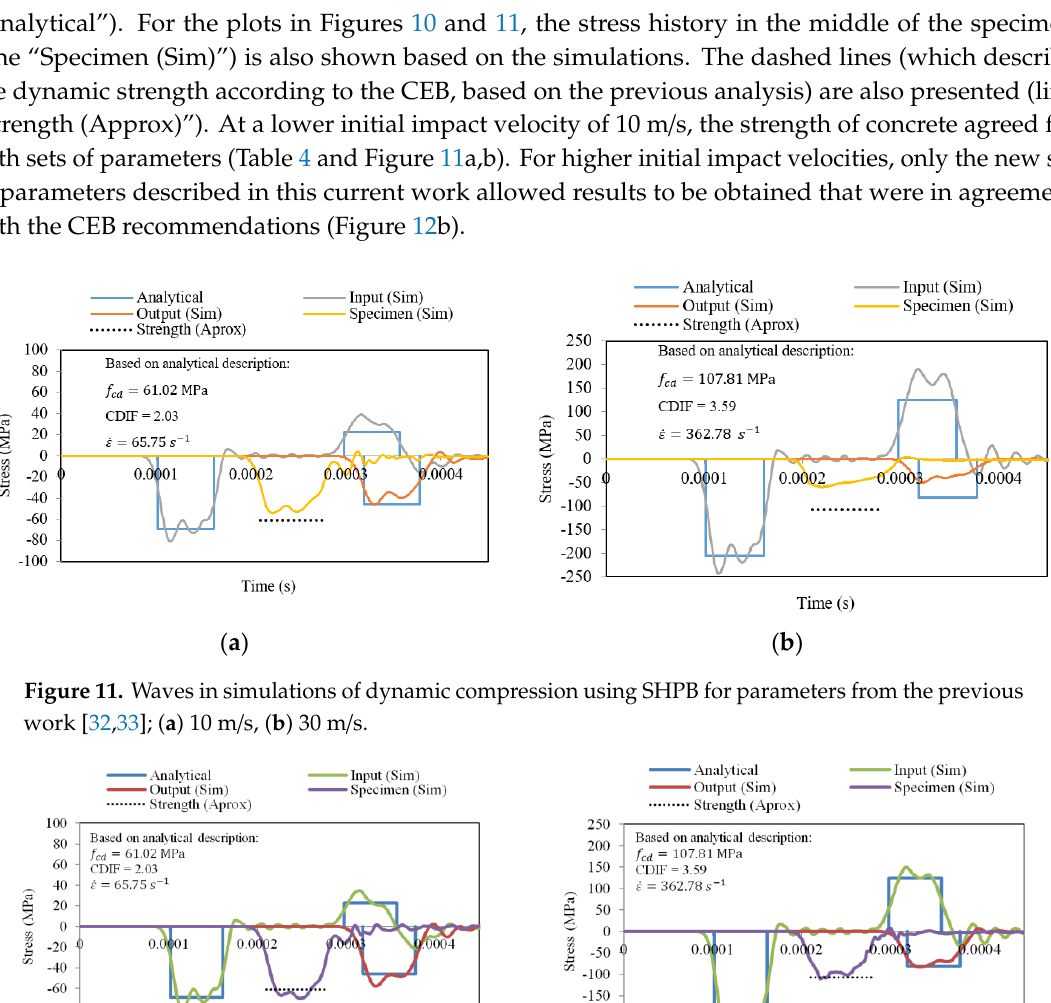
Figure 12. The waves in simulation of dynamic compression using SHPB for parameters from the